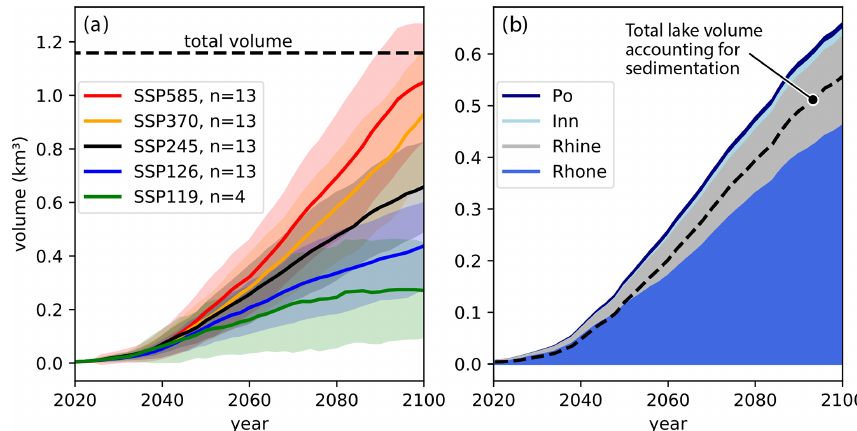
Figure 3. (a) Temporal evolution of the total potential glacier lake volume without sedimentation. The total possible volume (i.e. the maximal lake volume that would be realized if all glaciers were to vanish entirely) is indicated with the dashed line (95% confidence interval [1.05, 1.32]km 3 , not shown). Five different climate scenarios (SSPs) are distinguished. The shaded regions depict the spread between the results obtained with individual climate model chains. ( b ) Temporal evolution of the total potential glacier lake volume without sedimentation, aggregated for the four main river catchments in Switzerland (see Fig. 1). The results refer to the median scenario SSP245. The dashed line shows the total volume for all four catchments when taking the modelled sediment input into